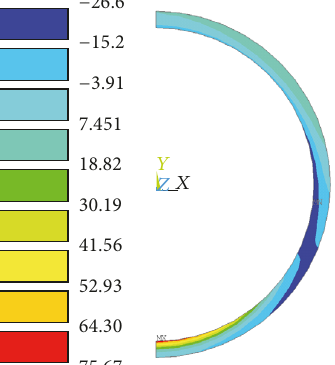
Figure 8: Longitudinal thermal stress distribution in the outlet header cross-section after 450 s [MPa].